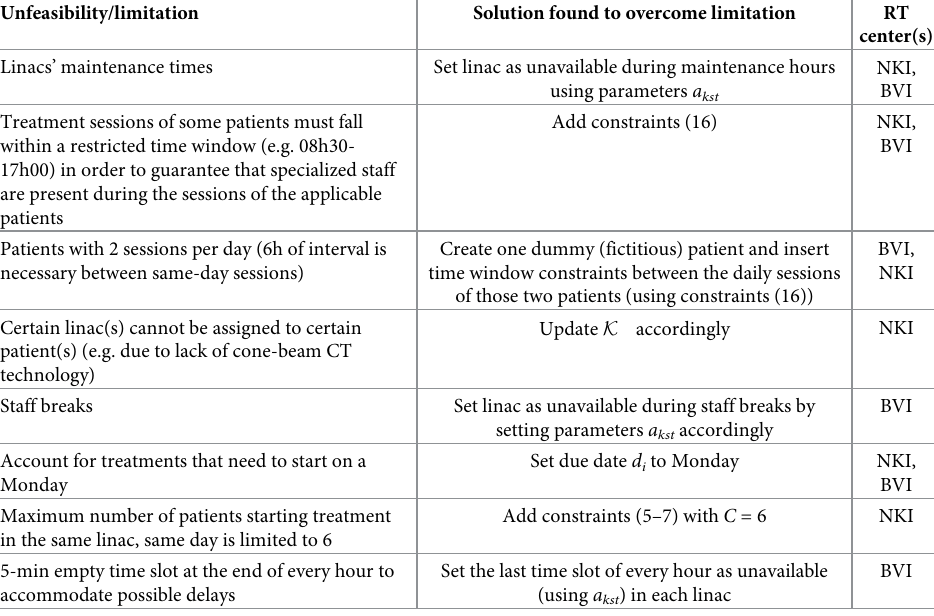
Table 3. Main infeasibilities and limitations found during the schedule construction method and corresponding model adjustments. Unfeasibility/limitation Solution found to overcome limitation RT Linacs’ maintenance times NKI,